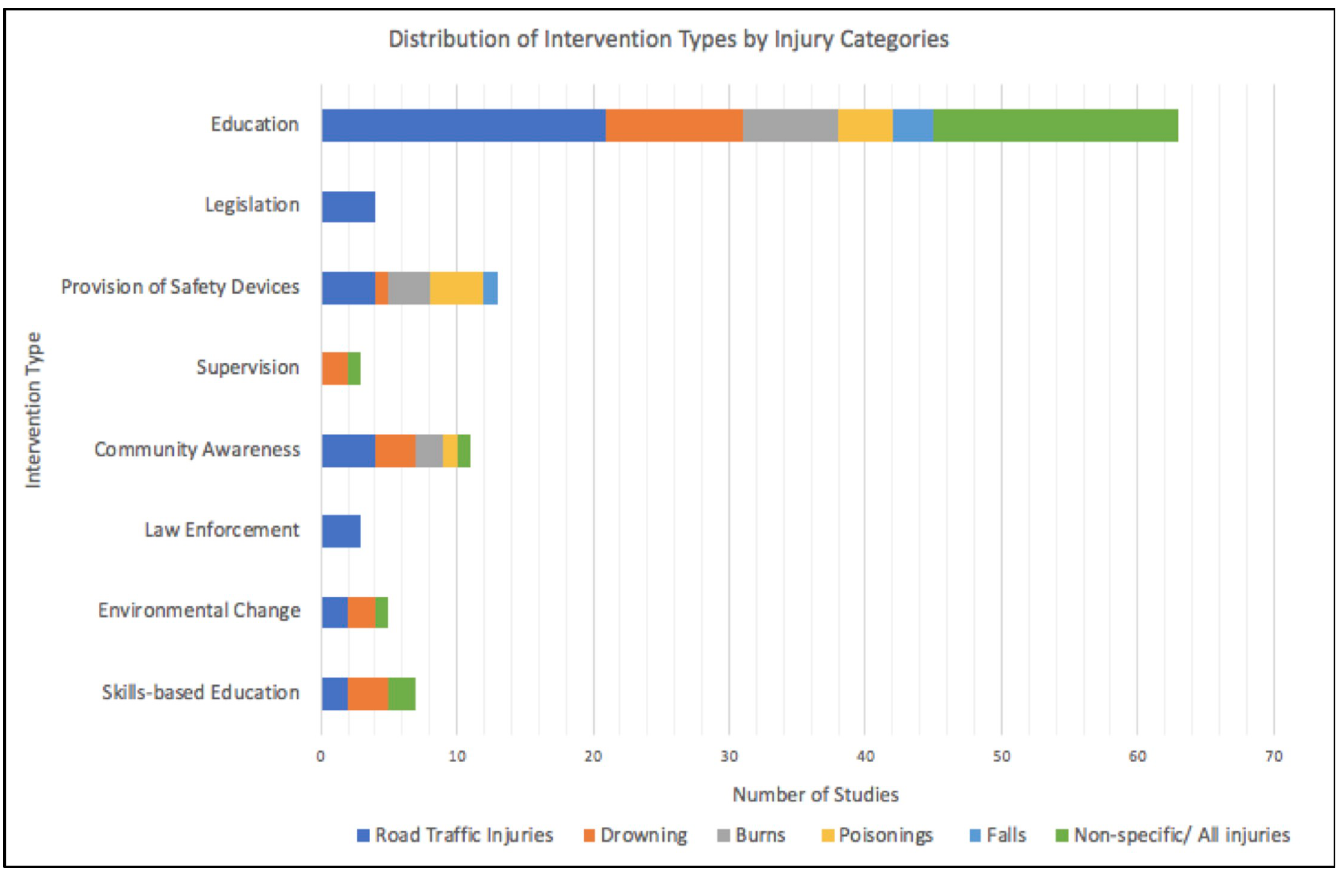
Fig 3. Distribution of intervention types by injury